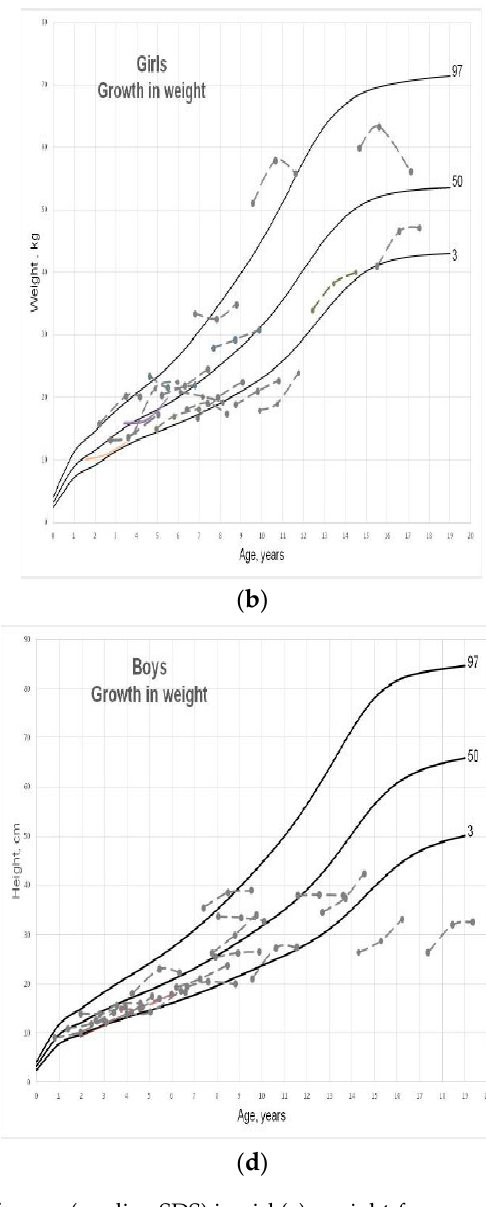
Table 2. Z-score delta changes of anthropometric measurements on patients on the ketogenic diet at 12 and 24 months.